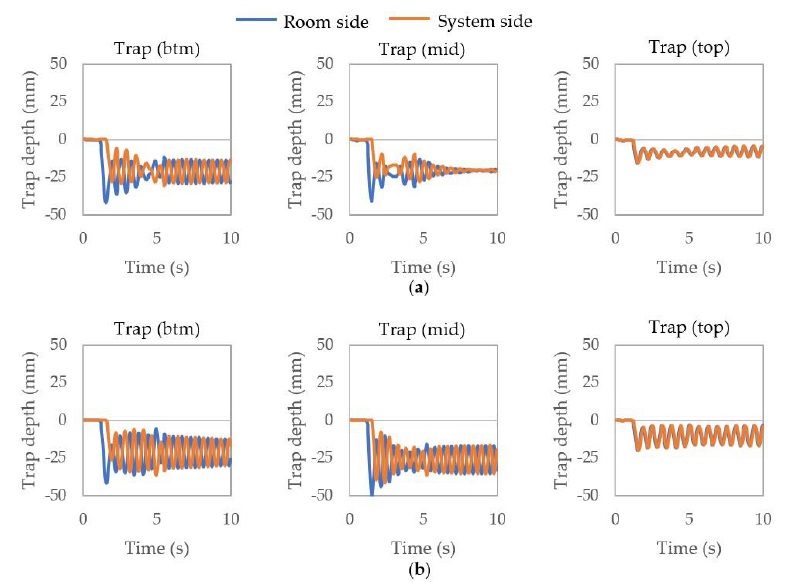
Figure 8. Simulated water-trap seal fluctuations for the 10 story building as a single-stack system with ( a ) 100 mm diameter stack and ( b ) 150 mm diameter